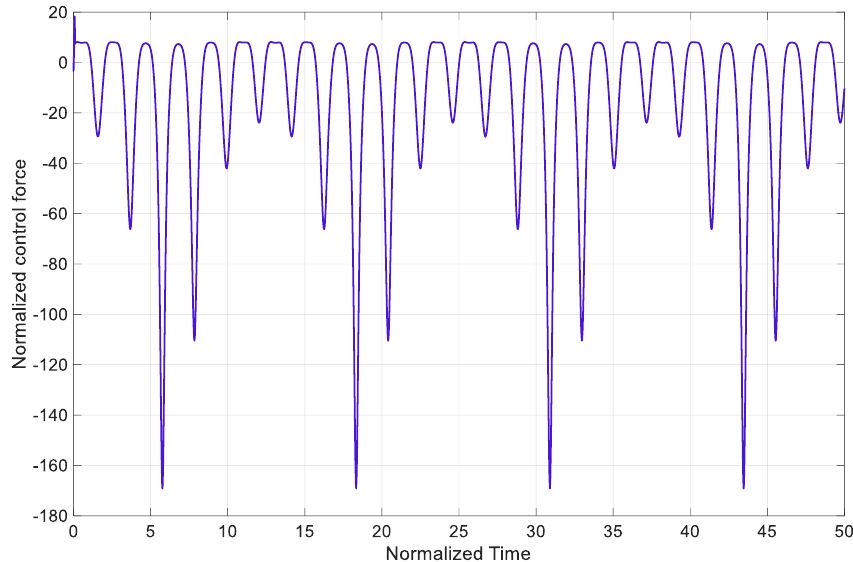
Figure 9. The control input for tracking of CNT with uncertain parameters and unknown disturb- ance.